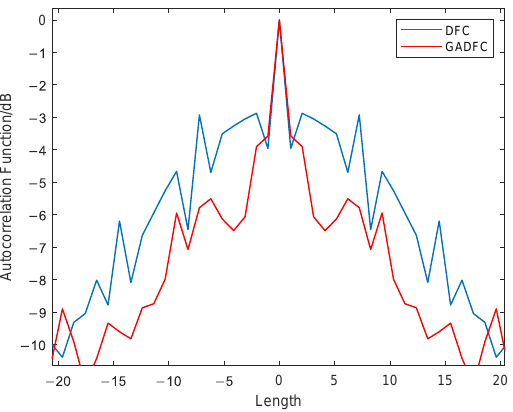
Figure 3. DFC Coding and GADFC Coding Autocorrelation Function Comparison.